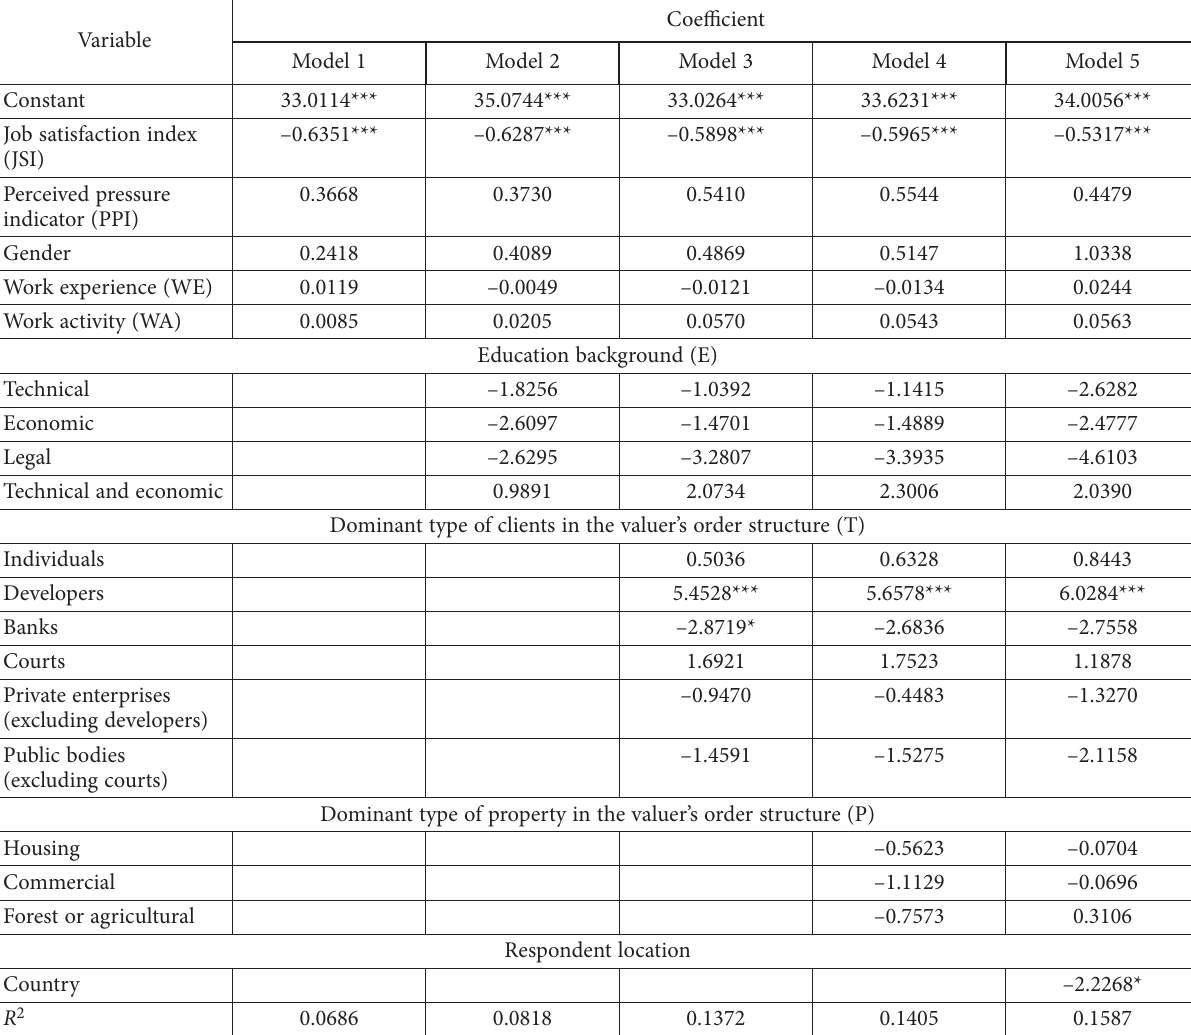
Table 2. Baseline models